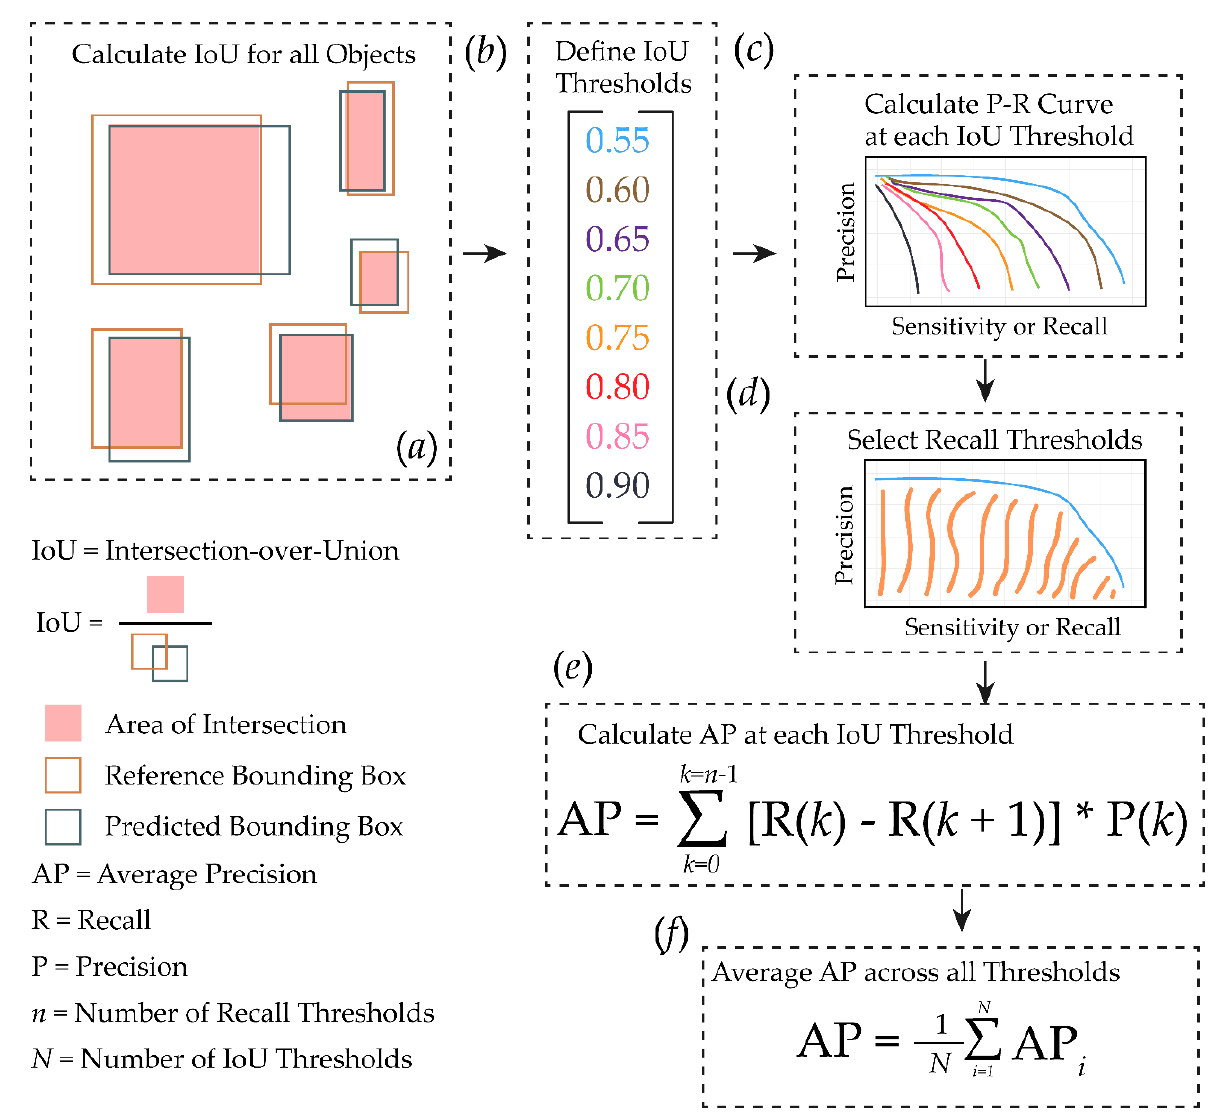
Figure 8. Conceptual explanation of average precision (AP) calculated using reference and predicted bounding boxes and eight IoU thresholds: ( a ) IoU for multiple map features; ( b ) Defined IoU thresholds at which to create P-R curves; ( c ) Multiple P-R curves, one for each defined IoU threshold; ( d ) Calculate area under each P-R curve; ( e ) Average AP calculated across all IoU thresholds; ( f ) Average AP across all thresholds.